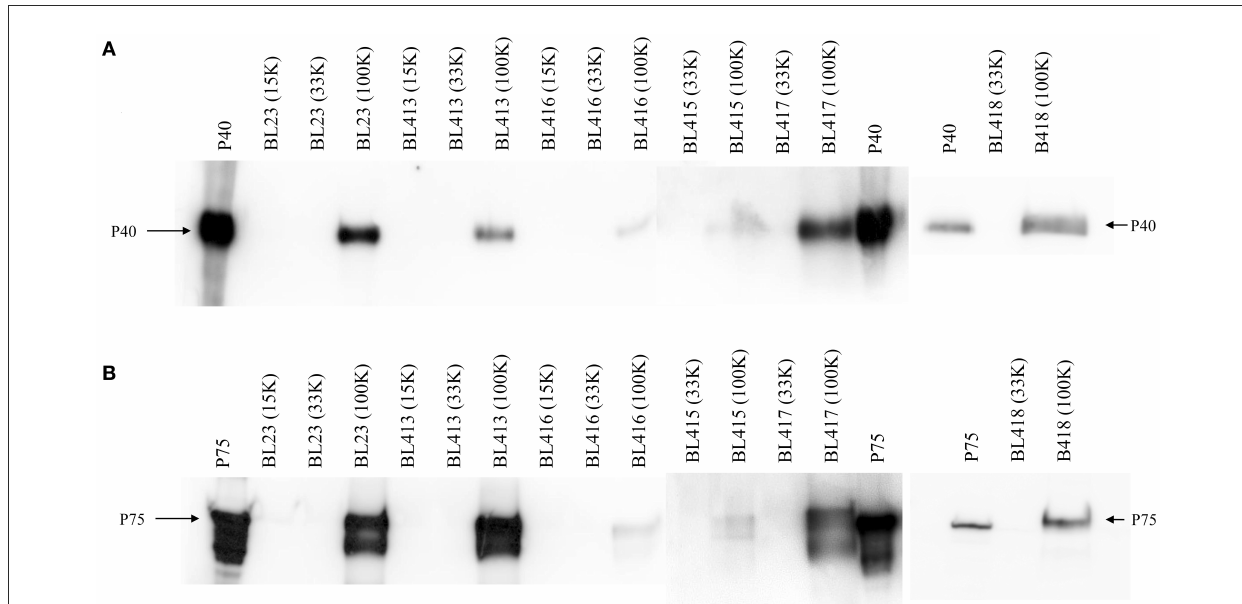
FIGURE1 Western blot showing proteins P40 (A) and P75 (B) in EV isolated from the reference strain of L. paracasei BL23 and L. paracasei isolated from dairy fermented products (BL 413 from product A, BL 415 from product Ca, BL 416 from product Co, BL 417 from product H, and BL 418 from product Y). Control lines carry purified proteins P40 and P75 from BL23.